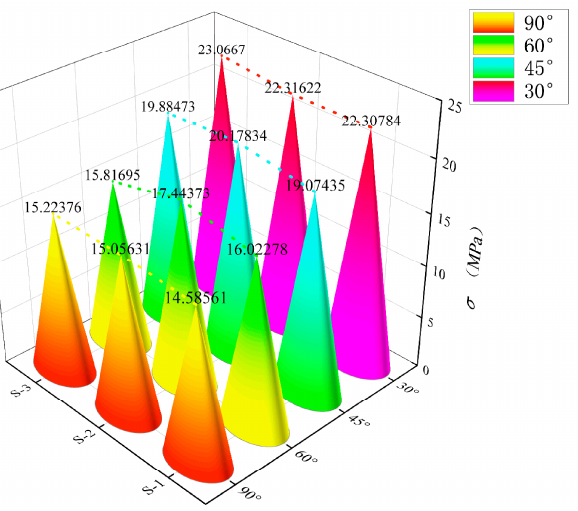
Figure 7. Ultimate bending stress of BTRC plates with different grid angles using the DL laying method.